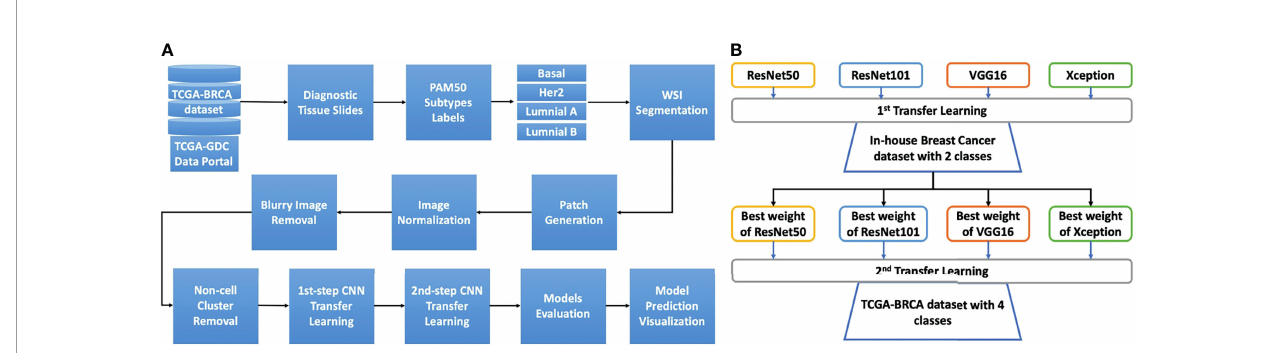
FIGURE 1 | The study design and details of the two-step transfer learning process with pretrained models. (A) The overall analysis pipeline. The diagnostic tissue slides of the TCGA-BRCA dataset were downloaded from the TCGA-GDC data portal. Afterward, to retrieve the PAM50 information for each patient, we used the information from the Cancer Genome Atlas Network study, and the cancer subtypes from patients were matched to the image slides for basal, HER2, luminal A, and luminal B These whole slides were then processed for segmentation to select the tiles (patches) with tissue content over 90%. The tiles were then normalized using the Macenko algorithm. Next, blurry tiles and non-cell cluster tiles were removed using Laplacian algorithm. The remaining tiles were then used for two-step transfer learning training. The trained models were then evaluated with the validation set for model selection. The model prediction was visualized using Grad-CAM techniques. (B) The two-step transfer learning scheme. Four models, namely, ResNet50, ResNet101, VGG16, and Xception, were used to develop the two-step transfer learning framework. The fi rst step transfer learning was done with weights from the ImageNet dataset for the aforementioned models. These models were trained with our in-house dataset of breast cancer comprising two classes of low and high risk of recurrence. The highest accuracy weights from each model were then used for the second step of transfer learning with the TCGA-BRCA dataset, which includes four classes (subtypes basal, HER2, luminal A, and luminal